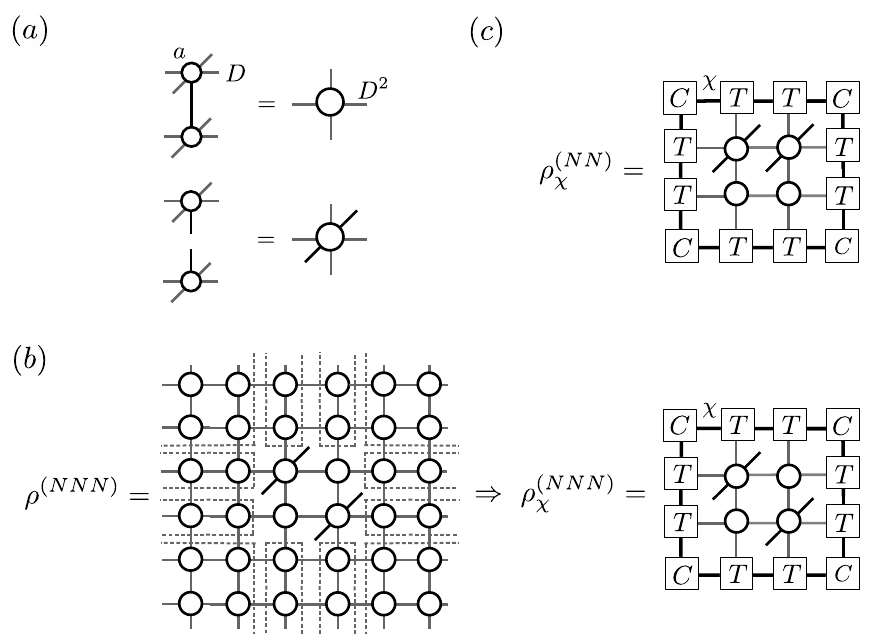
Figure 1: Definition of reduced-density matrices necessary for evaluating the energy − J per site of the J model over single-site iPEPS with C symmetry. (a) Double- 1 2 4 v layer tensors with contracted and uncontracted physical indices. (b) Infinite tensor network corresponding to the next-nearest-neighbour ρ ( NNN ) as approximated by ρ ( NNN ) in the finite network with C and T tensors resulting from CTM. (c) Finite- χ network approximation of nearest-neighbour ρ ( NN ) within the same 2 × 2 χ